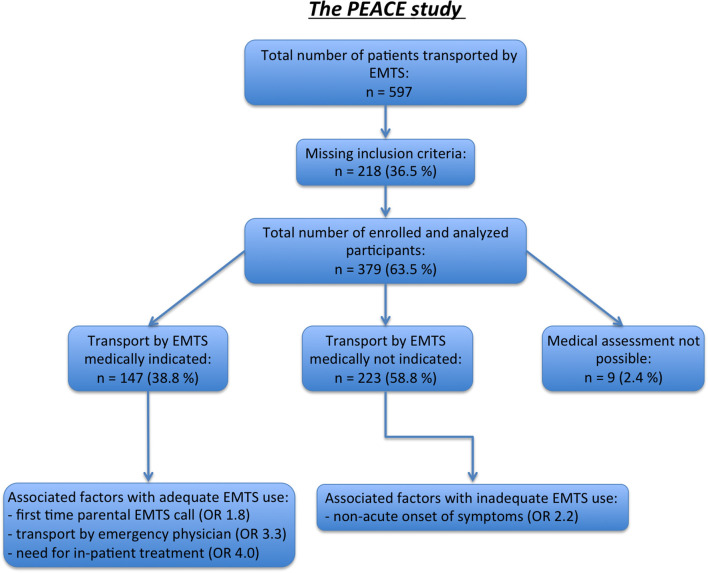
STROBE flowchart.